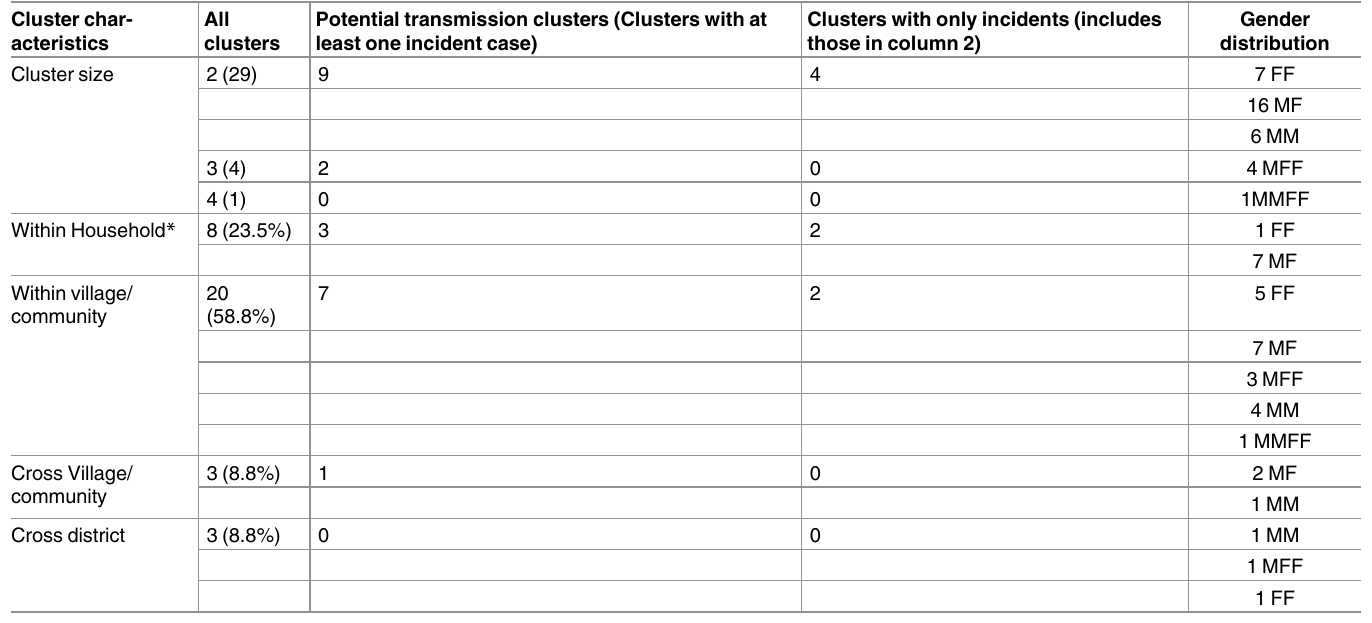
Table 3. Characteristics of 34 clusters identified in gag or env gene regions for 283 HIV-infected participants